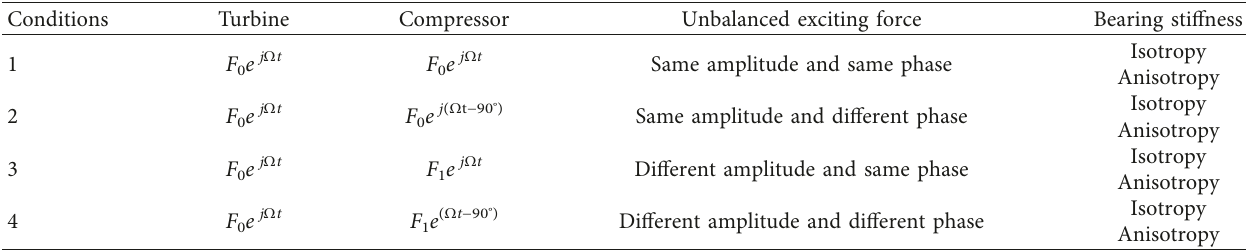
Table 2: Applying condition for unbalanced exciting force.